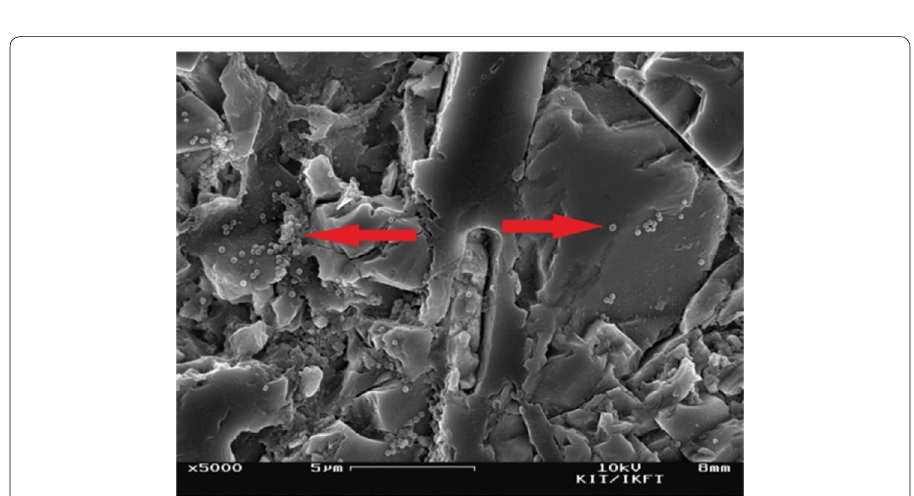
Fig. 19 SEM (SE image) of barite with numerous spherical phases formed on its crystal phases, sample 7.2 (PV07; 60 °C/20